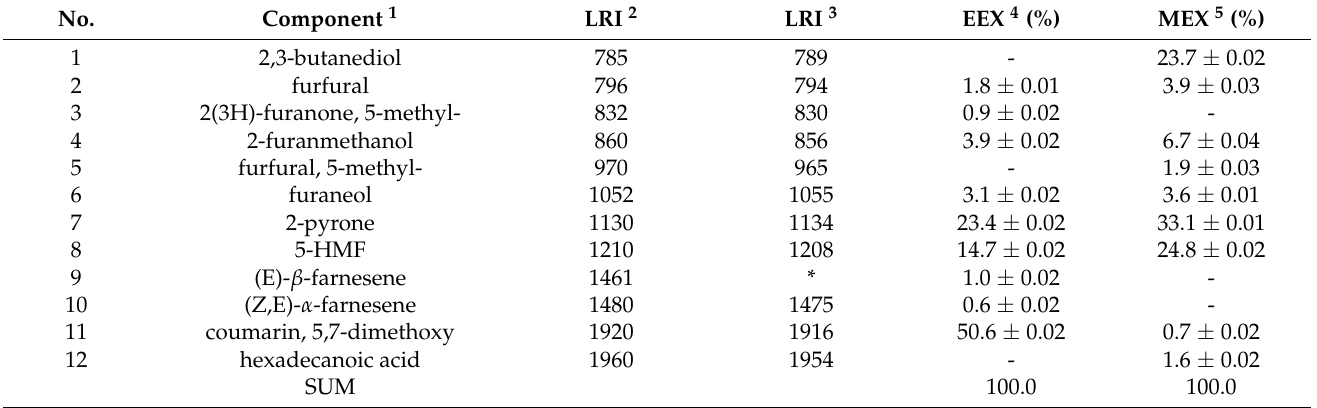
Table 2. Chemical composition (percentage mean value ± standard deviation) of exocarp and mesocarp